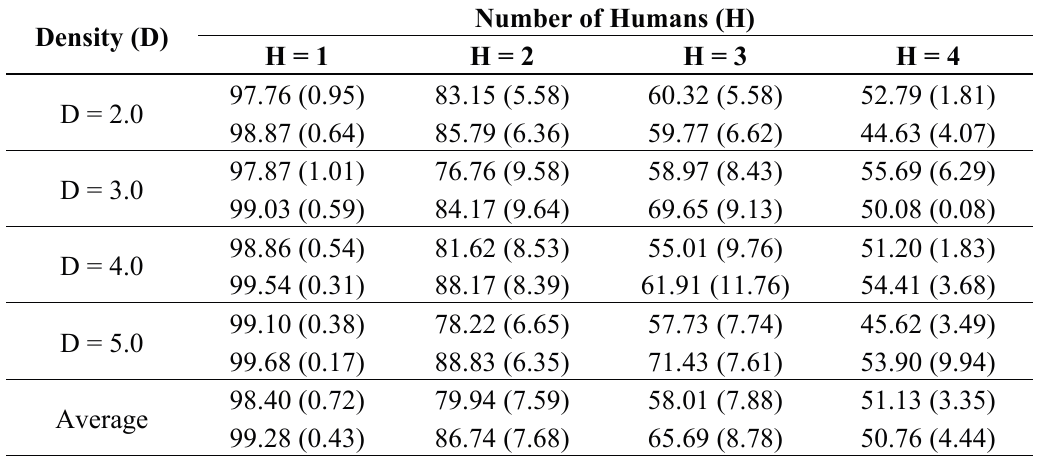
Table 5. Success detection rate of number of humans (Unit: